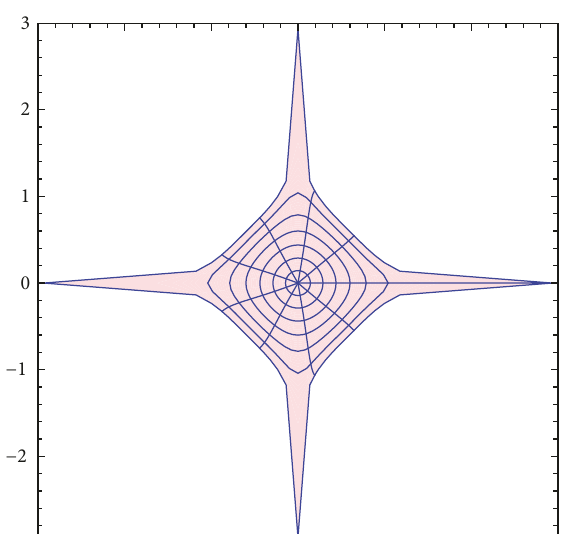
Figure 1: Images of |𝑧| = 𝑟 < 1 under 𝑓 1 . Figure 2: Images of |𝑧| = 𝑟 < 1 under 𝑓